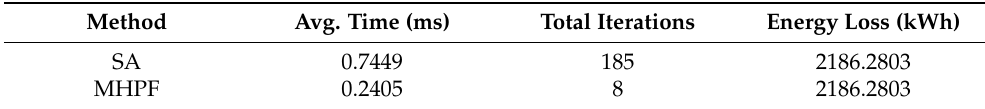
Table 1. Hourly power flow numerical